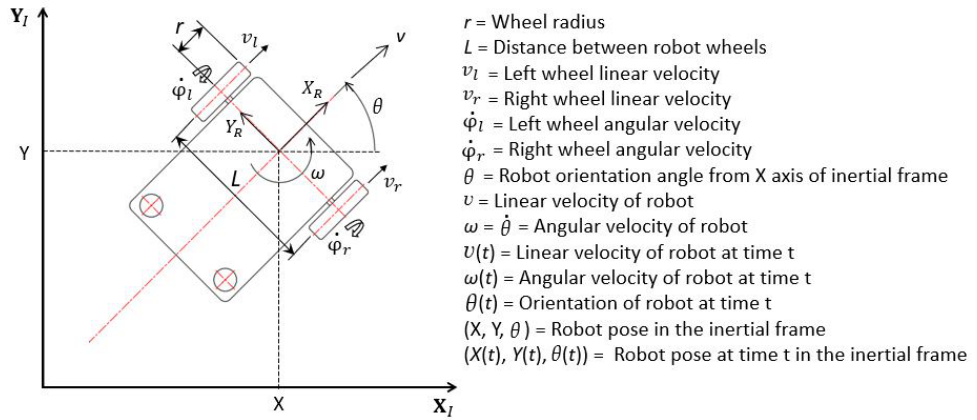
Figure 7. Differential drive